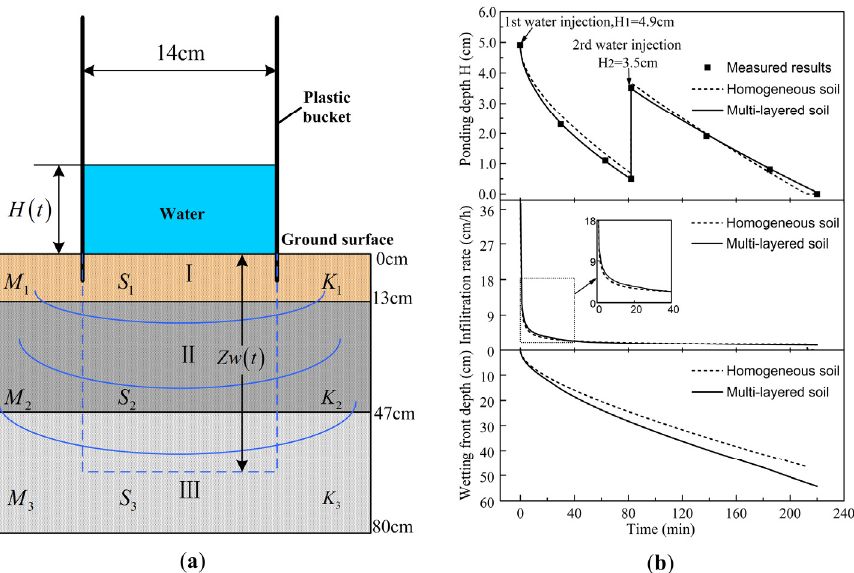
Figure 6. Ponding infiltration experiment on the field: ( a ) schematic diagram; ( b ) modeling results of homogeneous and multilayered cases.